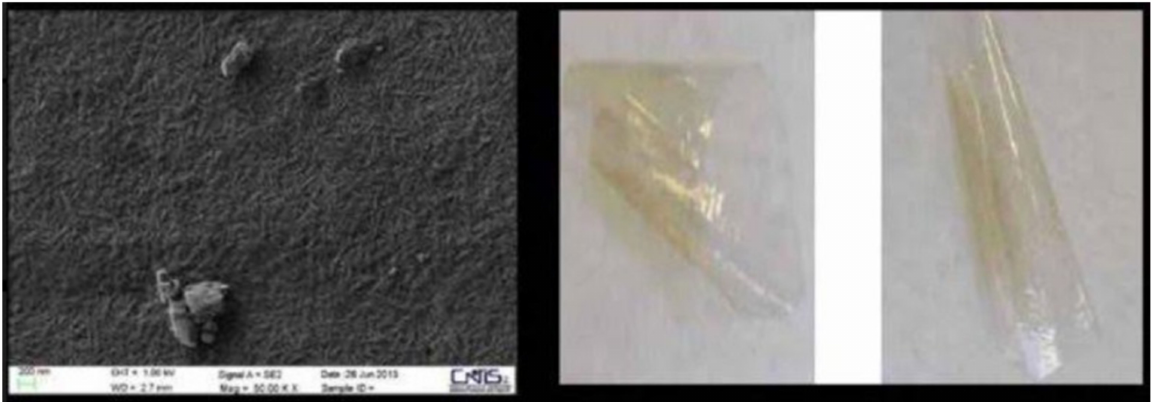
Figure 8. Chitin films (on the right ) with its photo at SEM ( left ) where shorter fibers with no porosity